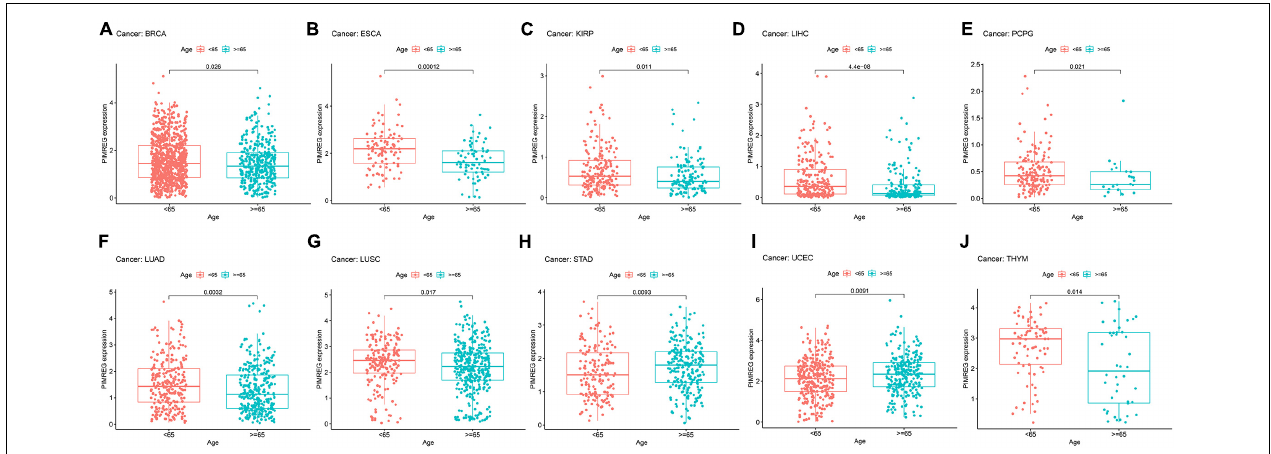
FIGURE 8 | Relationship between the expression of PIMERG and age in panel (A) breast cancer (BRCA), (B) esophageal cancer (ESCA), (C) kidney papillary cell carcinoma (KIRP), (D) liver cancer (LIHC), (E) pheochromocytoma and paraganglioma (PCPG), (F) lung adenocarcinoma (LUAD), (G) lung squamous cell carcinoma